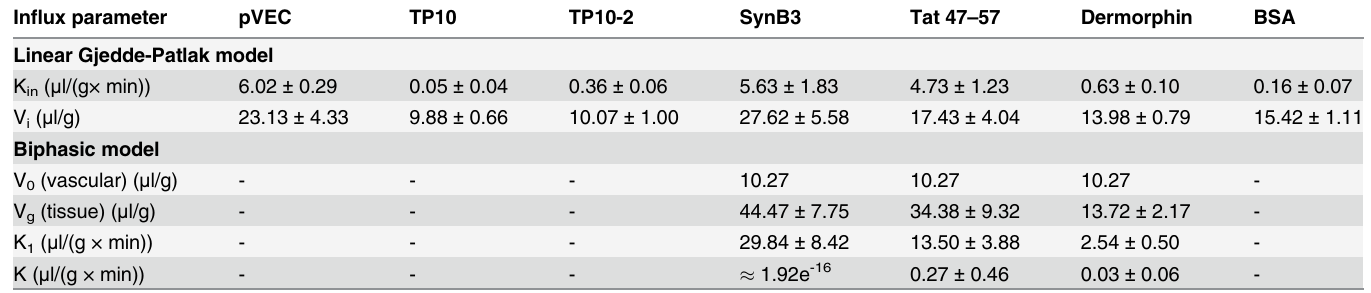
Table 2. Overview of the quantitative influx characteristics ( ± 65% confidence limits) of the five investigated CPPs based on linear and biphasic modeling of the multiple time regression analysis